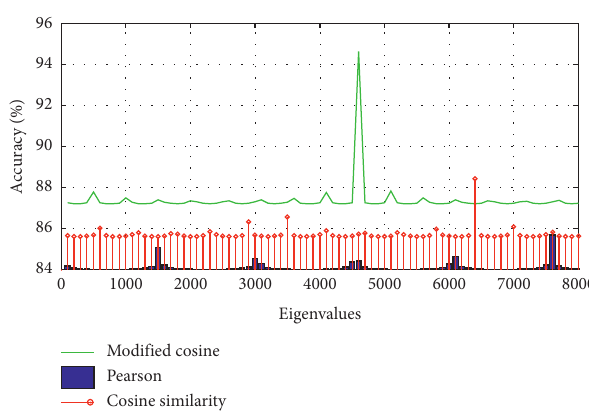
Figure 7: Comparison of accuracy of different similarity calcu- lation functions.